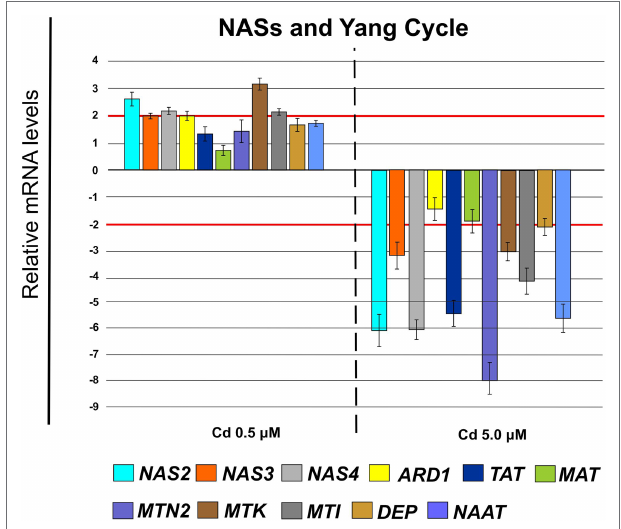
FIGURE 12 | Expression analysis of genes coding for nicotianamine synthases (NASs) and enzymes involved in the pathway of Yang Cycle in roots (15 days from sprouting and from the start of Cd treatments). NAS2 ( nicotianamine synthase 2 ), NAS3 ( nicotianamine synthase 3 ) and NAS4 ( nicotianamine synthase 4 ), ARD1 ( acireductone dioxygenase 1 ), TAT ( tyrosine transaminase 1 ), MAT ( S-adenosyl-L-methionine synthase ), MTN2 ( methylthioadenosine nucleosidase 2 ), MTK ( S-methyl-5-thioribose kinase ), MTI ( 5-methylthioribose kinase 1 ), DEP ( dehydratase/enolase/ phosphatase ), NAAT ( nicotianamine aminotransferase ). Red lines highlight the fold changes 2 and − 2 to graphically identify the genes differentially